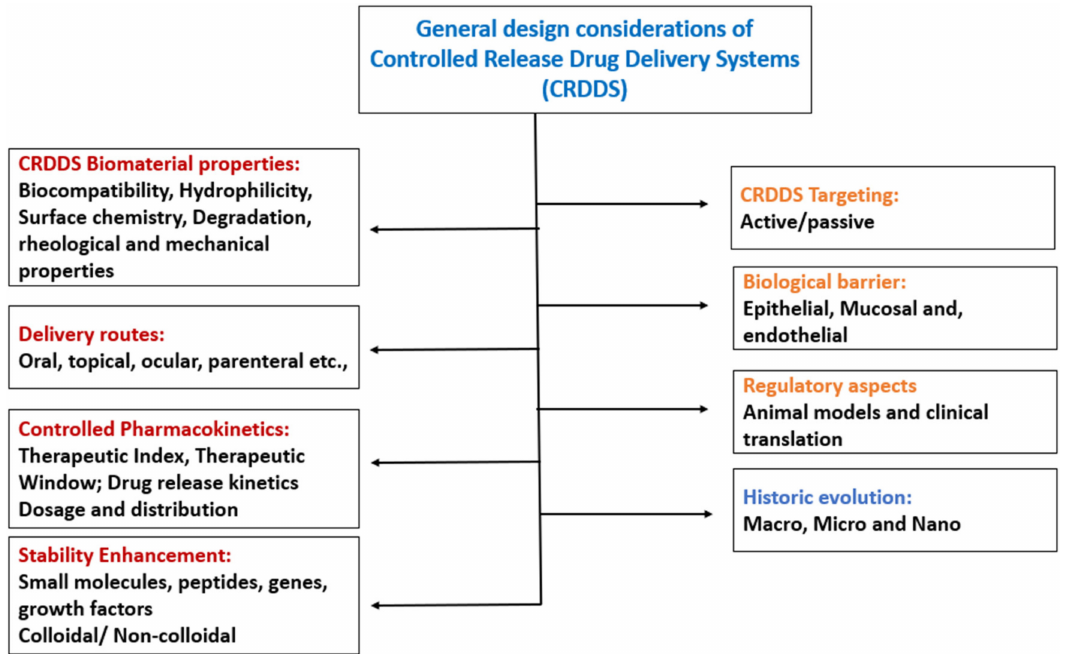
Figure 22. General design considerations of controlled release drug delivery systems